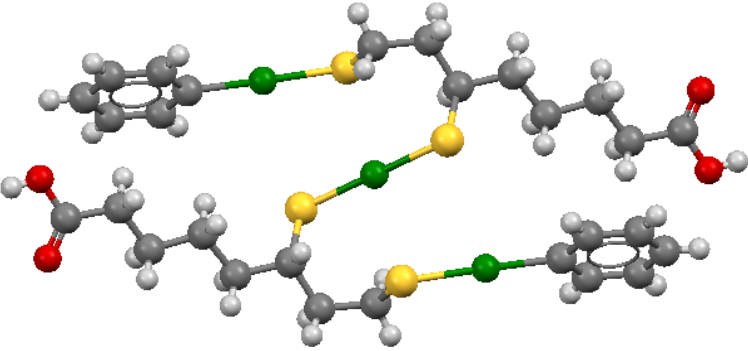
Figure 10. Mercury in green, sulfur in yellow, and oxygen in red. Coordinates obtained from the Cambridge Structural Database (Reference Code LIMNUQ; the image was created with Mercury3.5.